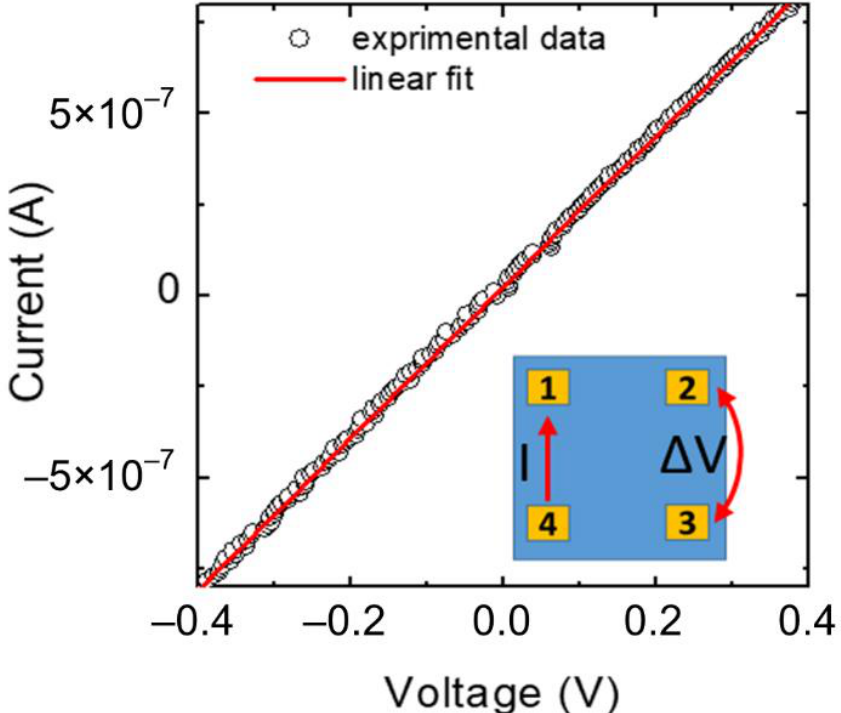
Figure 6. Typical current-voltage (I–V) measurement carried out on a Van der Pauw structure fabricated on Cu 2 O sample. The inset schematically illustrates the geometry on the sample and the electrical I-V measurement setup.